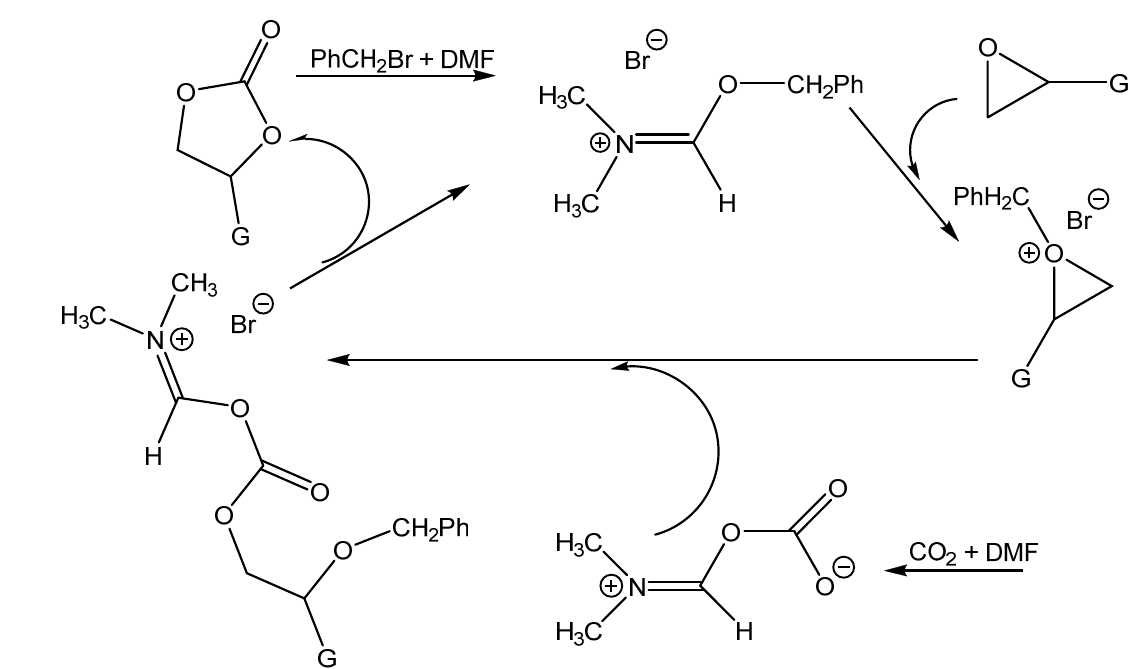
Table 16. The effect of organic bases on cycloaddition (compared with DBU in co-action with alkyl halides)